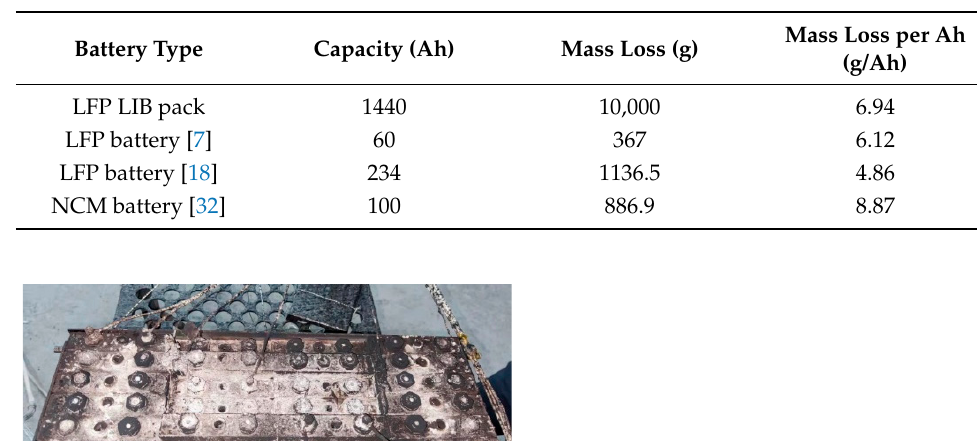
Table 1. Mass loss after the TR process.